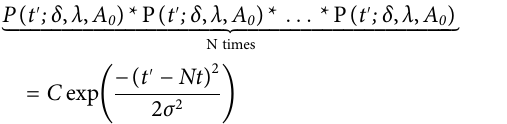
Frontiers in Physics |